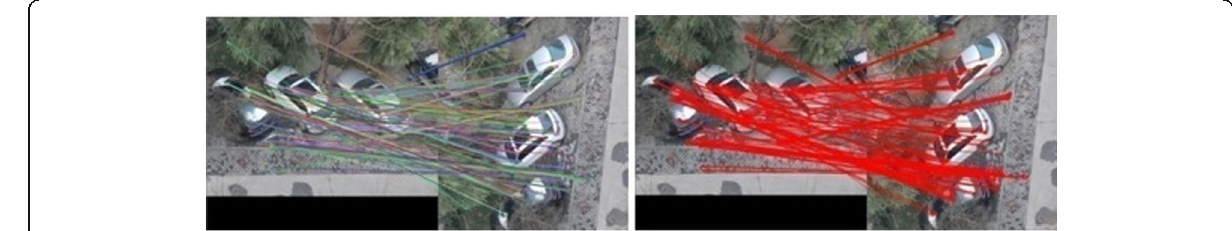
Fig. 11 Effect of the ORB algorithm on the same-scale image feature